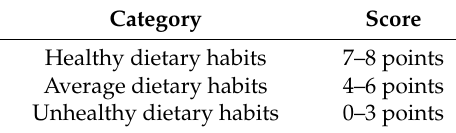
Table 2. Dietary Quality Score